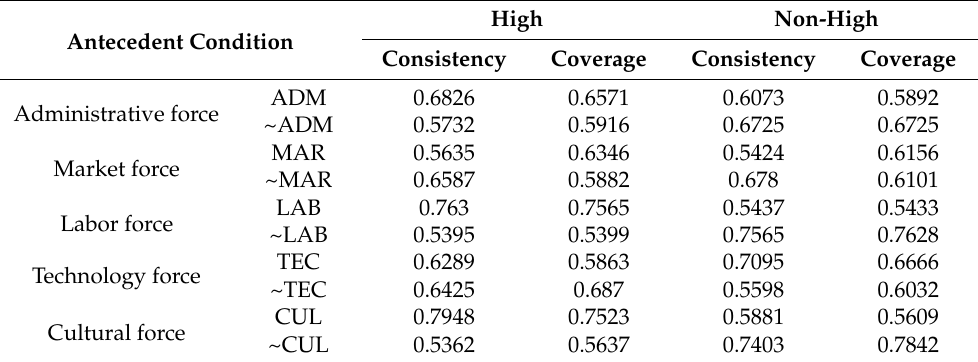
Table 7. Necessity analysis for high and non-high levels of rural resilience.